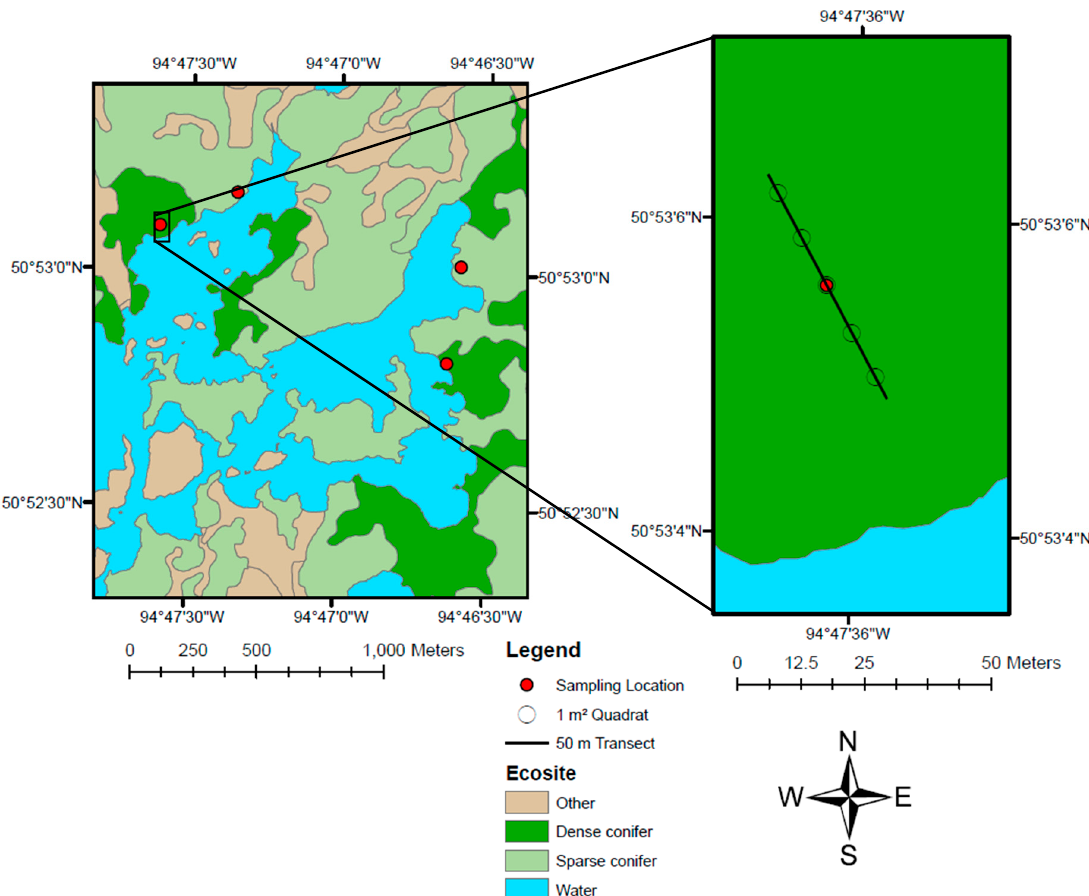
Figure 4. Field sampling protocol used to conduct vegetation surveys in a 12-year-old burn in Woodland Caribou Provincial Park, Ontario, Canada. Sampling was limited to dense conifer (dark green) and sparse conifer (light green) ecosites. Unsampled ecosites are coloured brown, lakes are coloured blue. Sampling locations (red dots) were marked by a GPS waypoint at the 25 m mark of the transect. The 50 m transect is represented by a black line and 1 m² quadrats are represented by open circles (right panel).